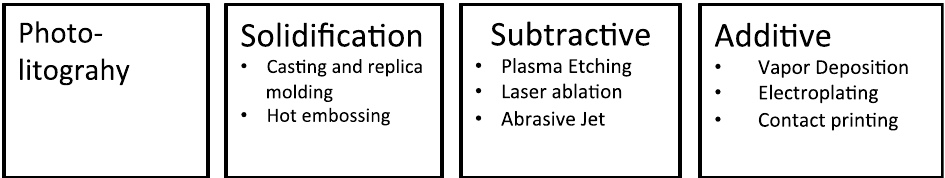
Figure 2. Broad categories of micro-fabrication processes for micro-channels [19].